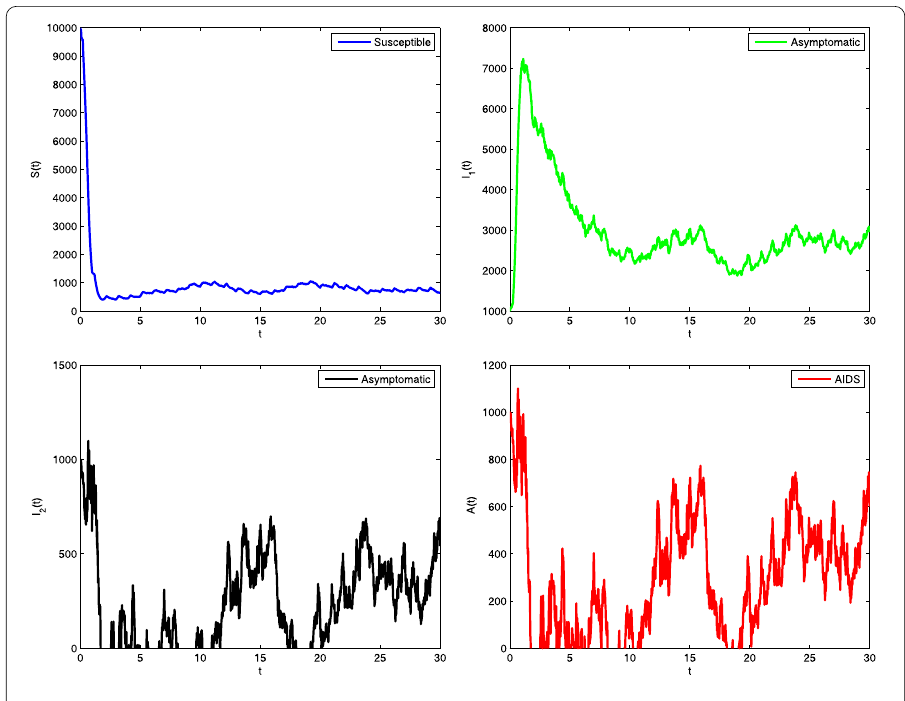
Figure 4 Simulations of system (1) with τ = 0.01, (cid:7) = 0.01, and ϕ = ϕ 1 = ϕ 2 = ϕ 3 = 0.1